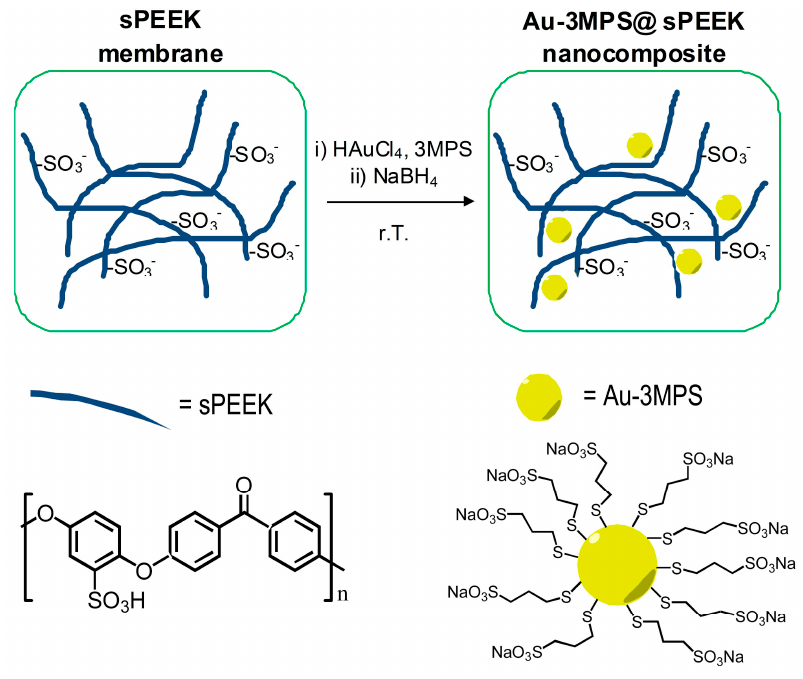
Figure 1. Schematization of the Au-3MPS@sPEEK nanocomposite formation.